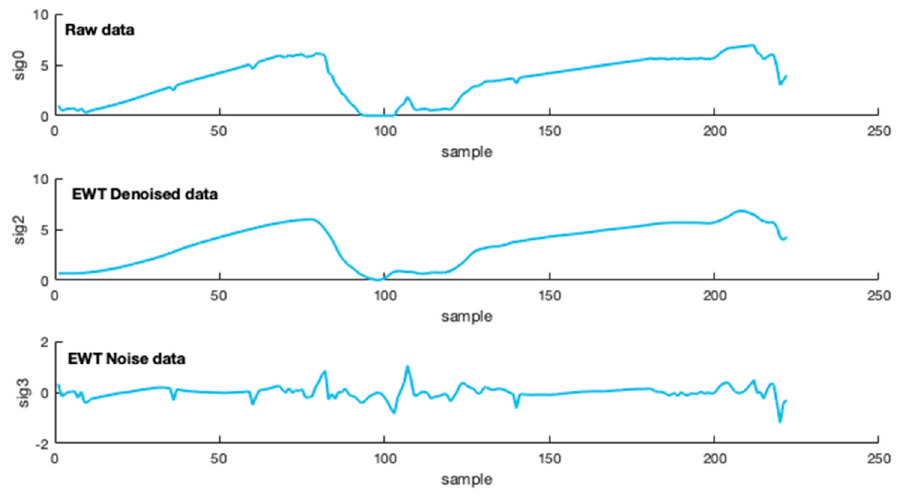
Figure 16. EWT decomposition of “front flat line 95.”